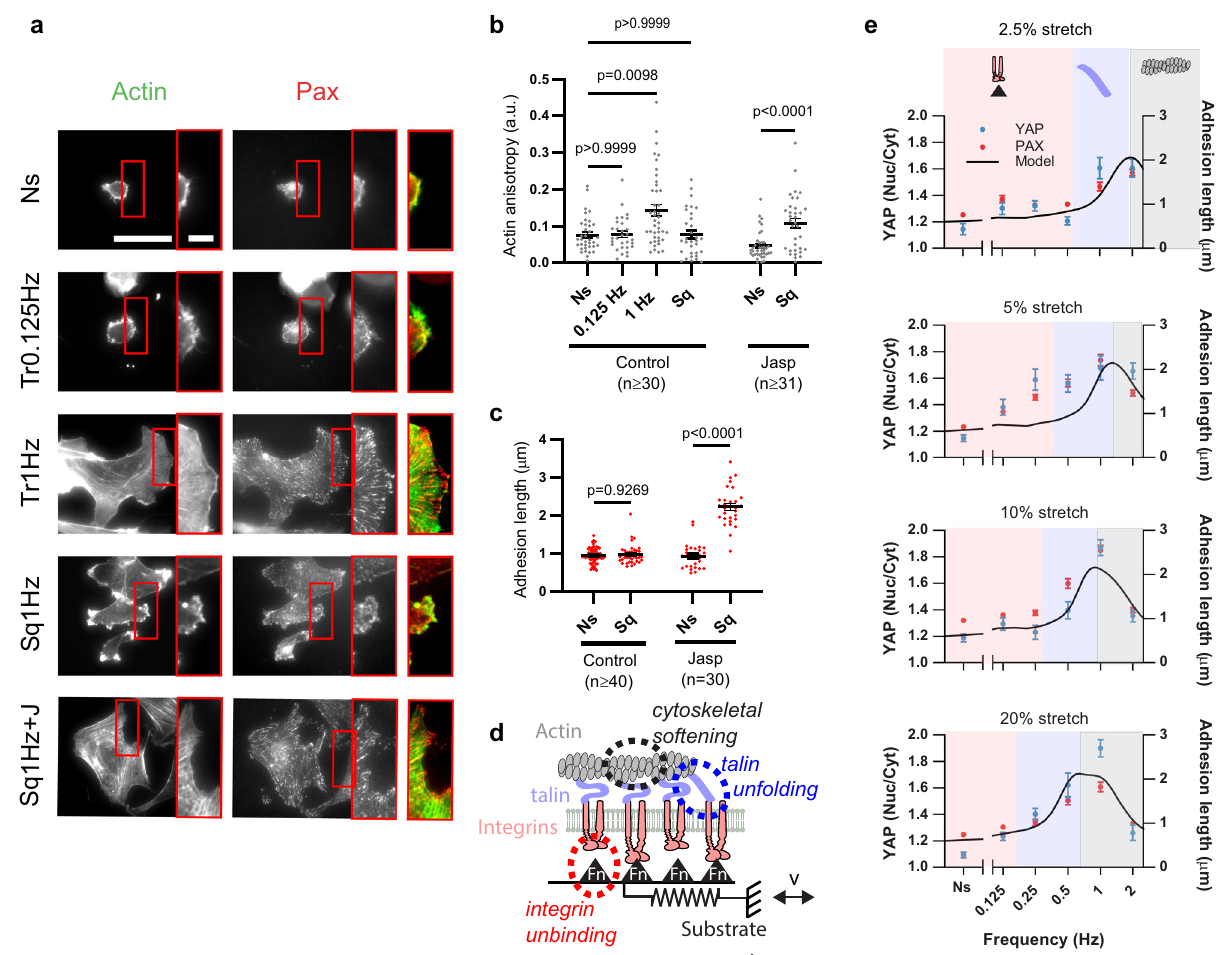
Fig. 2 A molecular clutch model considering mechanosensing and cytoskeletal softening predicts the response to stretch. a Actin and paxillin stainings for cells either not stretched or stretched by 10% with triangular signals (0.125 Hz, 1 Hz) or square signals (Sq, 1 Hz, with or without Jasplakinolide treatment). Areas circled in red are shown magni fi ed at the right of each image, and shown as a merged image (actin, green, paxillin, red). Scale bar is 50 µ m, and 10 µ m in magni fi cations. b , c corresponding quanti fi cations of actin anisotropy ( b ) and adhesion length ( c ) for control cells, and cells treated with Jasplakinolide. n numbers are cells. Statistical signi fi cance was assessed with two-way ANOVA. d Cartoon of computational clutch model (see “ Methods ” section). The model considers a relative speed of movement v between cell and substrate (given by stretch). The substrate is represented by an elastic spring with binding sites to integrins (via fi bronectin, Fn triangles), which in turn connect to talin and actin. As stretch applies forces, these can lead to integrin unbinding, talin unfolding, or cytoskeletal softening. e Model predictions (black line) overlaid on experimental YAP and paxillin results from Fig. 1. The only parameter changing between simulations is stretch amplitude (1.5, 2, 2.5, and 3 µ m for 2.5, 5, 10, and 20% stretch). Areas shaded in pink, blue, and gray show the regions dominated respectively by integrin unbinding, talin unfolding, and cytoskeletal softening. Data are shown as mean ±